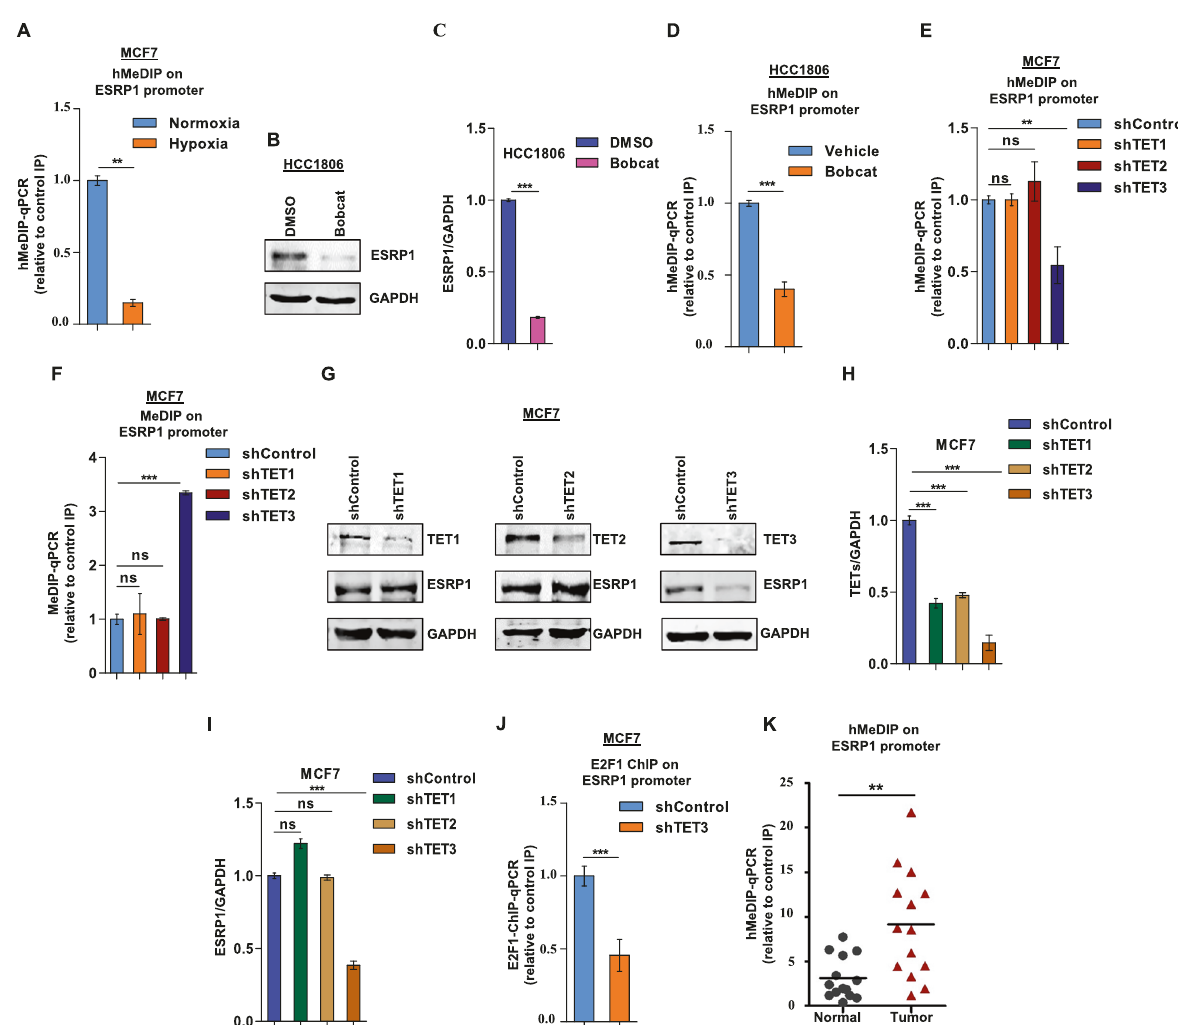
Fig. 4 Reduced CpG hydroxymethylation at the E2F1 binding motif contributes to ESRP1 downregulation under hypoxia. A hMeDIP of DNA isolated from MCF7 cells (Normoxia versus Hypoxia) using 5 hydroxymethylcytosine antibody followed by qRT-PCR, relative to input and control IgG ( n = 3). B Immunoblots of ESRP1 after bobcat (70 – 90 μ M) treatment under normoxia in HCC1806. C Densitometric analysis of representative blots. D hMeDIP in HCC1806 after bobcat (70 – 90 μ M) treatment under normoxia, followed by qRT-PCR relative to input and control IgG ( n = 3). E hMeDIP in MCF7 cells transfected with shRNA against TET1, TET2, TET3 versus shcontrol cells under normoxia, followed by qRT-PCR relative to input and control IgG ( n = 3). F MeDIP in MCF7 cells transfected with shRNA against TET1, TET2, TET3 versus shcontrol cells under normoxia, followed by qRT-PCR relative to input and control IgG ( n = 3). G Immunoblots of TET1, TET2, TET3, and ESRP1 protein expression in shTET1, shTET2, shTET3, and shcontrol MCF7 cells under normoxic condition. H , I Densitometric analysis of representative blots compared to shControl normalized to one. J ChIP qRT-PCR on ESRP1 promoter using E2F1 antibody in TET3 knockdown MCF7 cells under normoxia. Fold enrichment (E2F1/IgG) was normalized to 5% input. K hMeDIP in normal and breast tumor tissue genomic DNA and qRT-PCR of ESRP1promoter region relative to input and control IgG ( n = 14). Error bars show mean values ± SD ( n = 3 unless otherwise speci fi ed) calculated using two-tailed Student ’ s t test, ns (non-signi fi cant), * * P < 0.01 and ** * P <